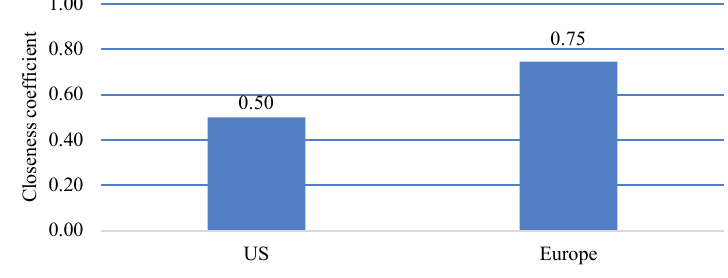
Fig. 6. Results of the TOPSIS analysis at different criteria weights according to the US